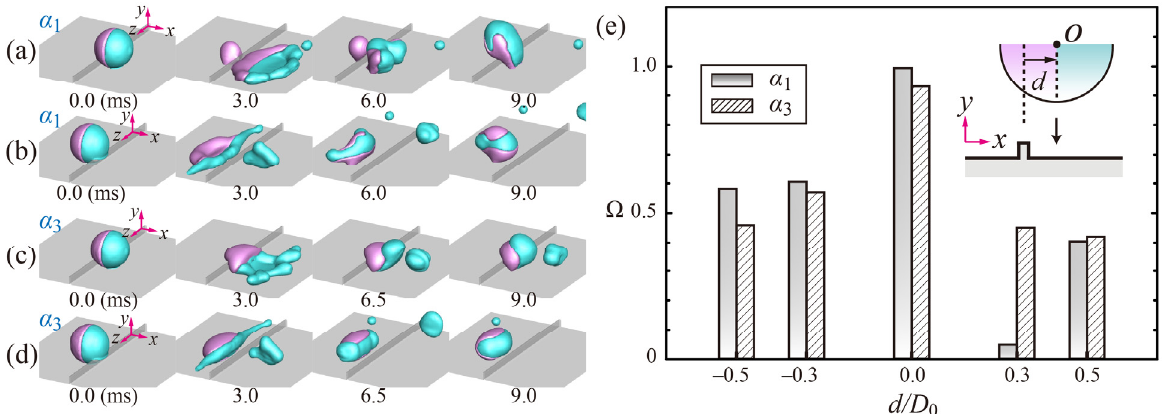
Figure A3. Off-centered Janus drop impact on the surfaces at We w = 61. Morphological behavior of the impinging drops at ( a , b ) d/D 0 = +0.3 and –0.3 under the viscosity ratio of α 1 , respectively, and ( c , d ) d/D 0 = +0.3 and –0.3 under the viscosity ratio of α 3 , respectively. ( e ) The ratio Ω as a function of d/D 0 under the viscosity ratios of α 1 and α 3 .